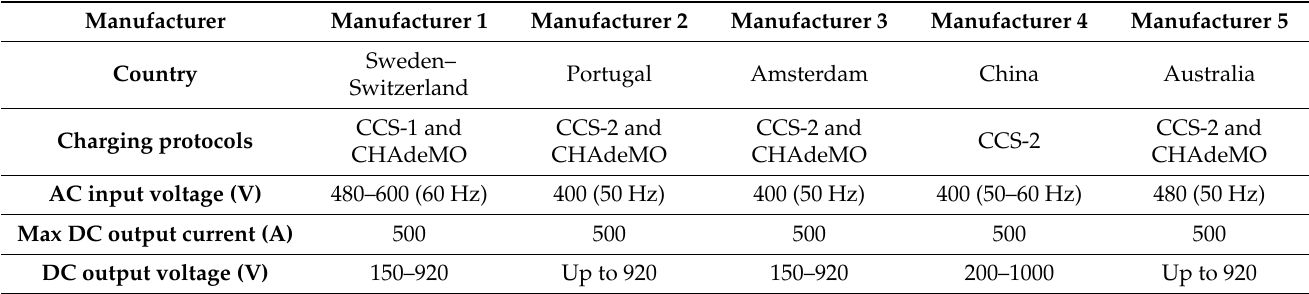
Table 2. Electrical specifications of ultra-fast chargers from certain manufacturers.